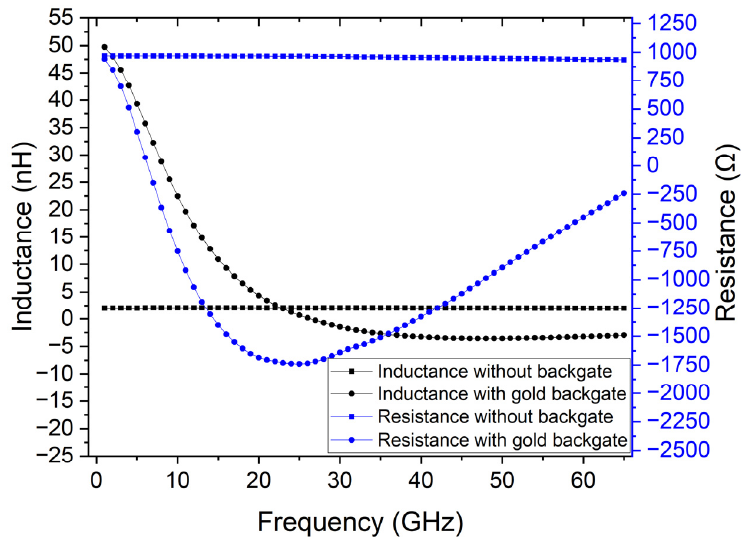
Figure 8. Comparison of the simulated and extracted DUT’s characteristics without the backgate and with a 10 nm thick gold backgate.